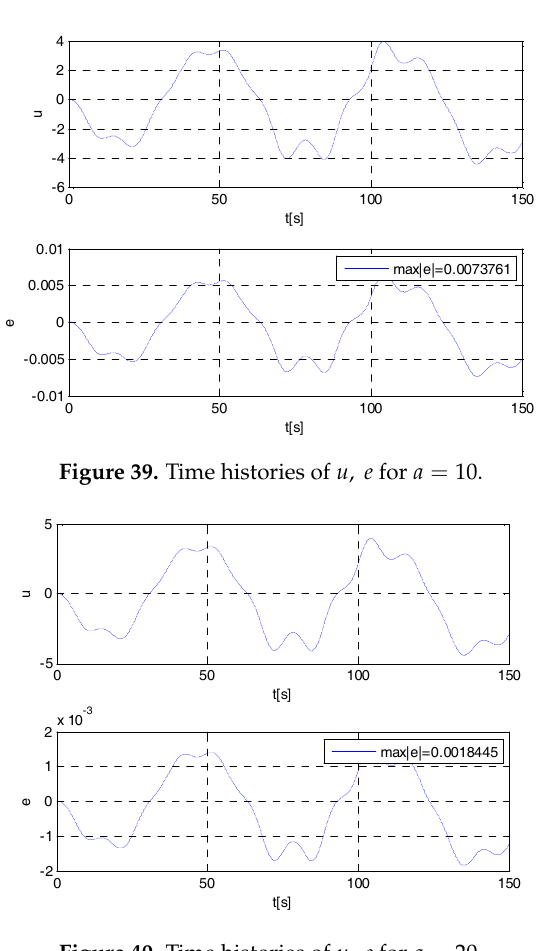
Figure 40. Time histories of u , e for a = 20 .